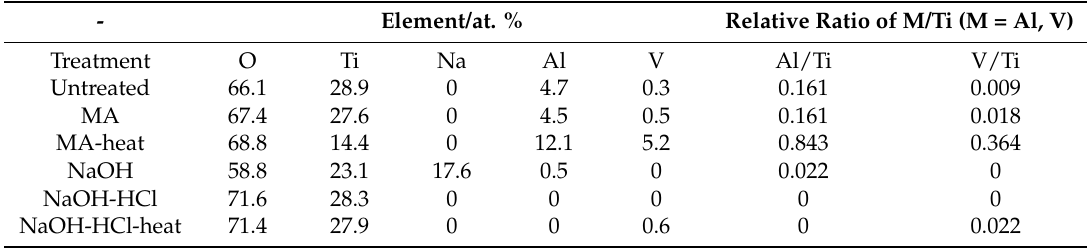
Table 1. Results of X-ray photoelectron spectroscopy (XPS) quantitative analysis on the surfaces of Ti–6Al–4V alloy untreated and subjected to acid and heat treatments with or without NaOH treatment. - Element/at. % Relative Ratio of M/Ti (M = Al, V) Treatment O Ti Na Al V Al/Ti V/Ti Untreated 66.1 MA